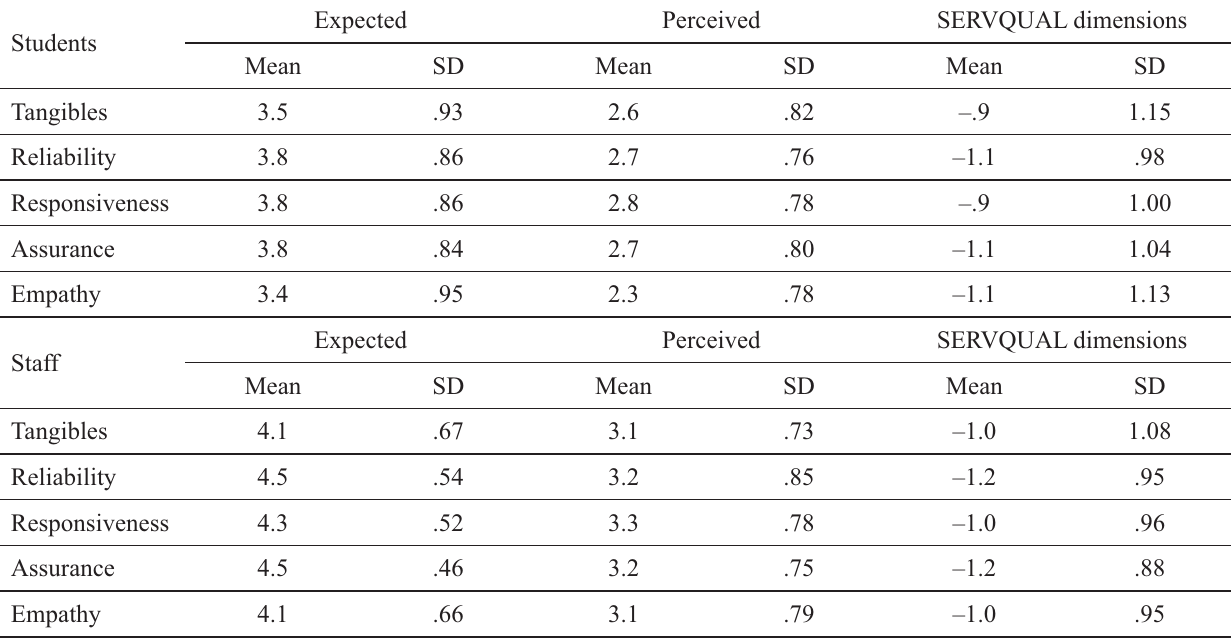
Table 4. Mean scores of SERVQUAL